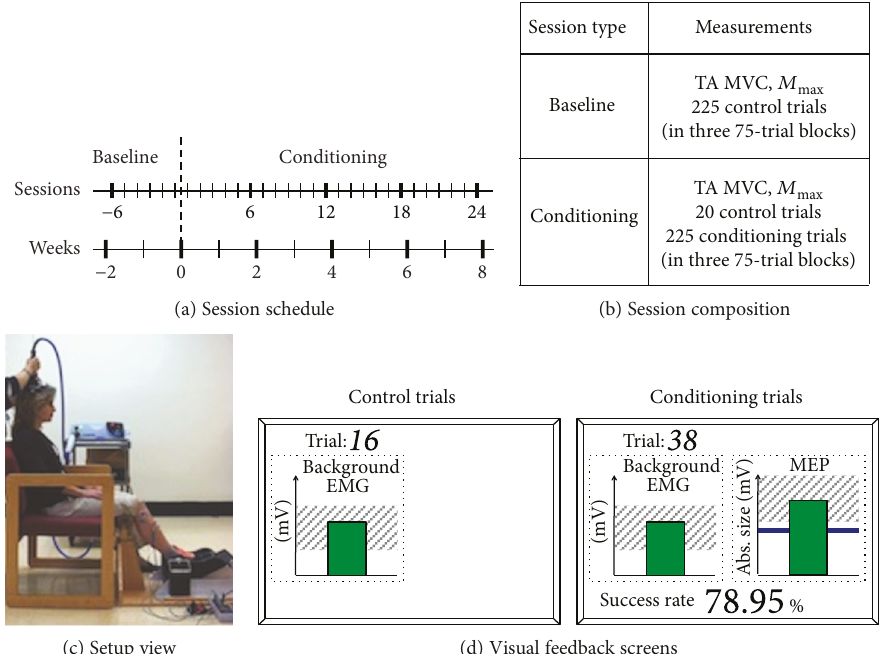
Figure 1: (a) Session schedule. Six baseline sessions are followed by 24 conditioning sessions. (b) Composition of baseline and conditioning sessions. (c) Setup view. The subject sits in a chair with hip, knee, and ankle angles fi xed at ≈ 100 ° , ≈ 120 ° , and ≈ 110 ° , respectively, in a custom- made apparatus. (d) Visual feedback screens for control and conditioning trials. In all trials, the number of the current trial within its block is displayed, and the background EMG panel shows the correct range (shaded) and the current value (green vertical bar, updated every 200 ms). If TA EMG activity stays in the correct range for at least 2s and at least 5.5 s has passed since the last trial, an MEP is elicited. In control trials (left), the MEP panel is not shown. In conditioning trials (right), the shading in the MEP panel indicates the rewarded MEP range for up-conditioning. The dark horizontal line is the average MEP size of the baseline sessions, and the vertical bar is the MEP size (i.e., the average recti fi ed EMG in the MEP interval (e.g., 45 – 75ms after TMS)) for the most recent trial (it appears 200 ms after TMS). If that MEP size reaches into the shaded area, the bar is green and the trial is a success. If it falls below the shaded area, the bar is red and the trial is a not a success. The running success rate for the current block is shown at the bottom.